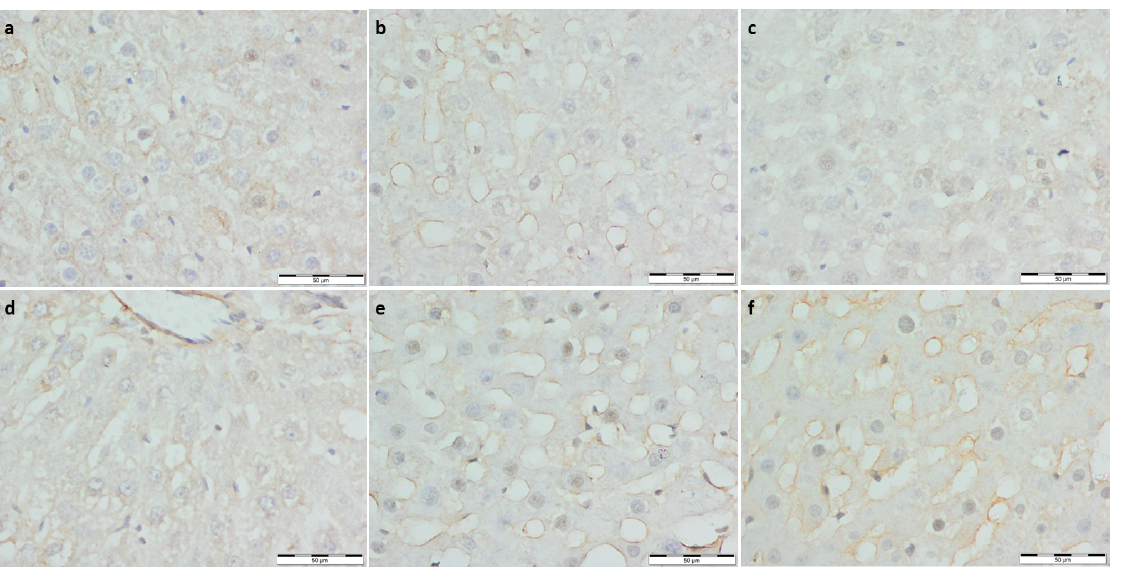
Figure 3. ( a ) Con-Sed, ( b ) Con-Run, ( c ) WP-Sed, ( d ) BP-Sed, ( e ) WP-Run and ( f ) BP-Run; immuno-